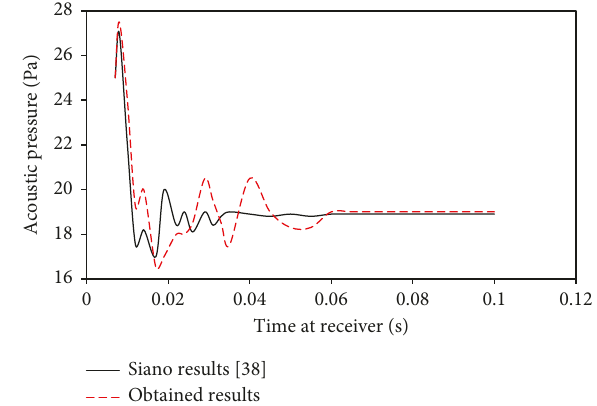
Figure 8: Comparison of the obtained acoustic pressure and the reported experimental results of Siano et al. [38] at a train speed of